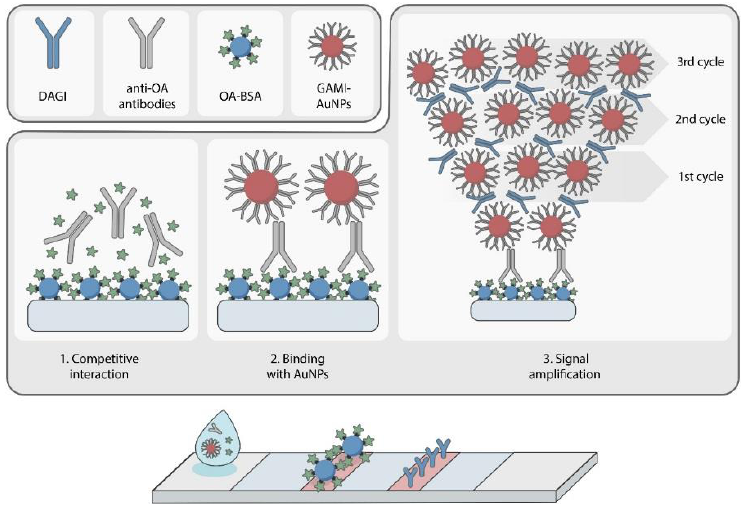
Figure 4. Scheme of the LFIA with cascade signal amplification.